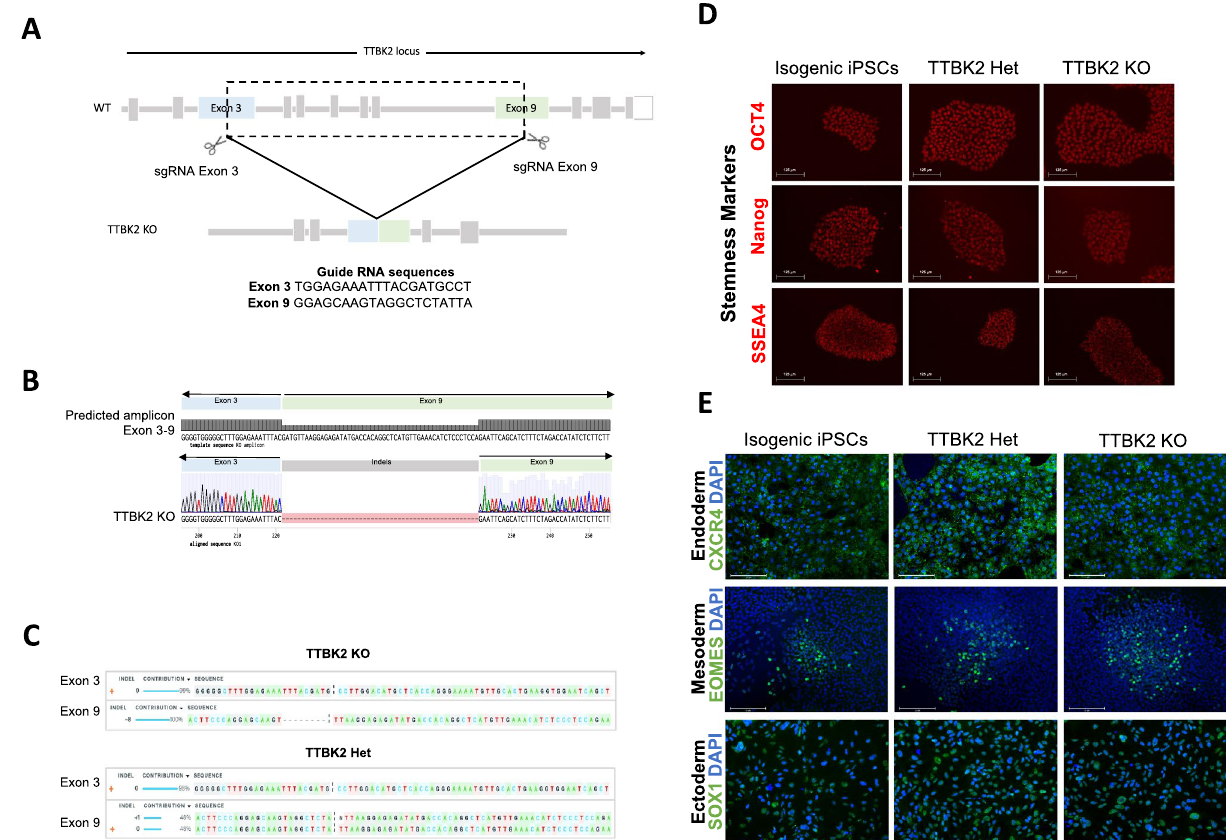
Figure 6. Generation and characterization of TTBK2 knockout iPSCs using CRISPR/Cas9. ( A ) Diagram depicting the TTBK2 locus, the sites on exon 3 and exon 9 targeted by guide RNAs, and the predicted deletion from exon 3–9. Guide RNA sequences for each exon are included below the illustration. ( B ) Graphic showing an alignment of the predicted amplicon resulting from deletion between exon 3 and exon 9 and the Sanger sequence for the TTBK2 KO clone, confirming genomic deletion in one allele. ( C ) Inference of CRISPR Edits (ICE) analysis illustrating the modifications of exon 3 and exon 9 in the homozygous (TTBK2 KO) and heterozygous (TTBK2 Het) edited cells. ( D ) Immunofluorescent staining of stemness markers OCT4 (octamer- binding transcription factor 4), Nanog (Nanog homeobox), and SSEA4 (stage-specific embryonic antigen-4) in isogenic, TTBK2 Het, and TTBK2 KO cells. All markers and their labels are red. Isogenic iPSCs are included for reference. ( E ) Immunofluorescent staining of endoderm (CXCR4, C-X-C motif chemokine receptor 4), mesoderm (EOMES, eomesodermin), and ectoderm (SOX1, SRY-box transcription factor 1) markers illustrating the capability of the homozygous (TTBK2 KO) and heterozygous (TTBK2 Het) edited cells to differentiate into the three germ layers. Isogenic iPSCs are included for